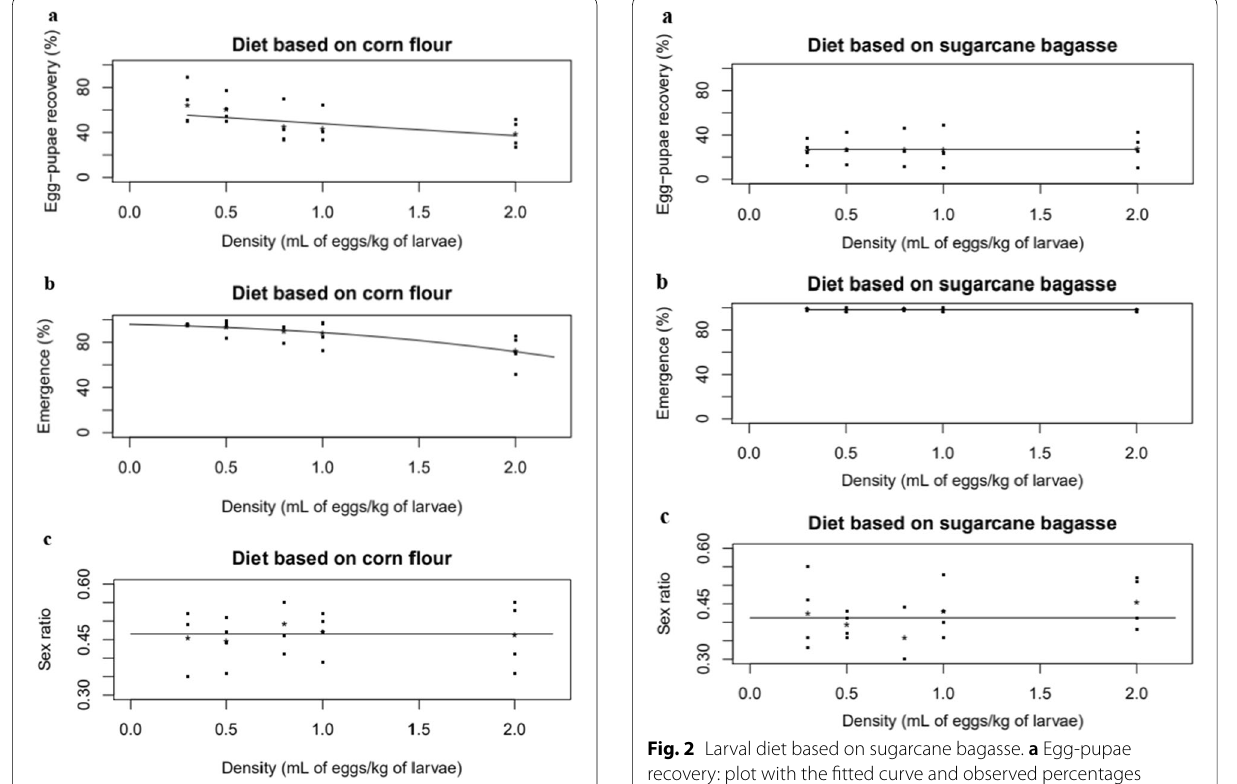
Fig. 1 Larval diet based on corn flour. a Egg-pupae recovery: plot with the fitted curve and observed percentages versus density. b Emergence: plot with the fitted curve and observed percentages versus density. c Sex ratio: plot with the fitted curve and observed proportions versus density